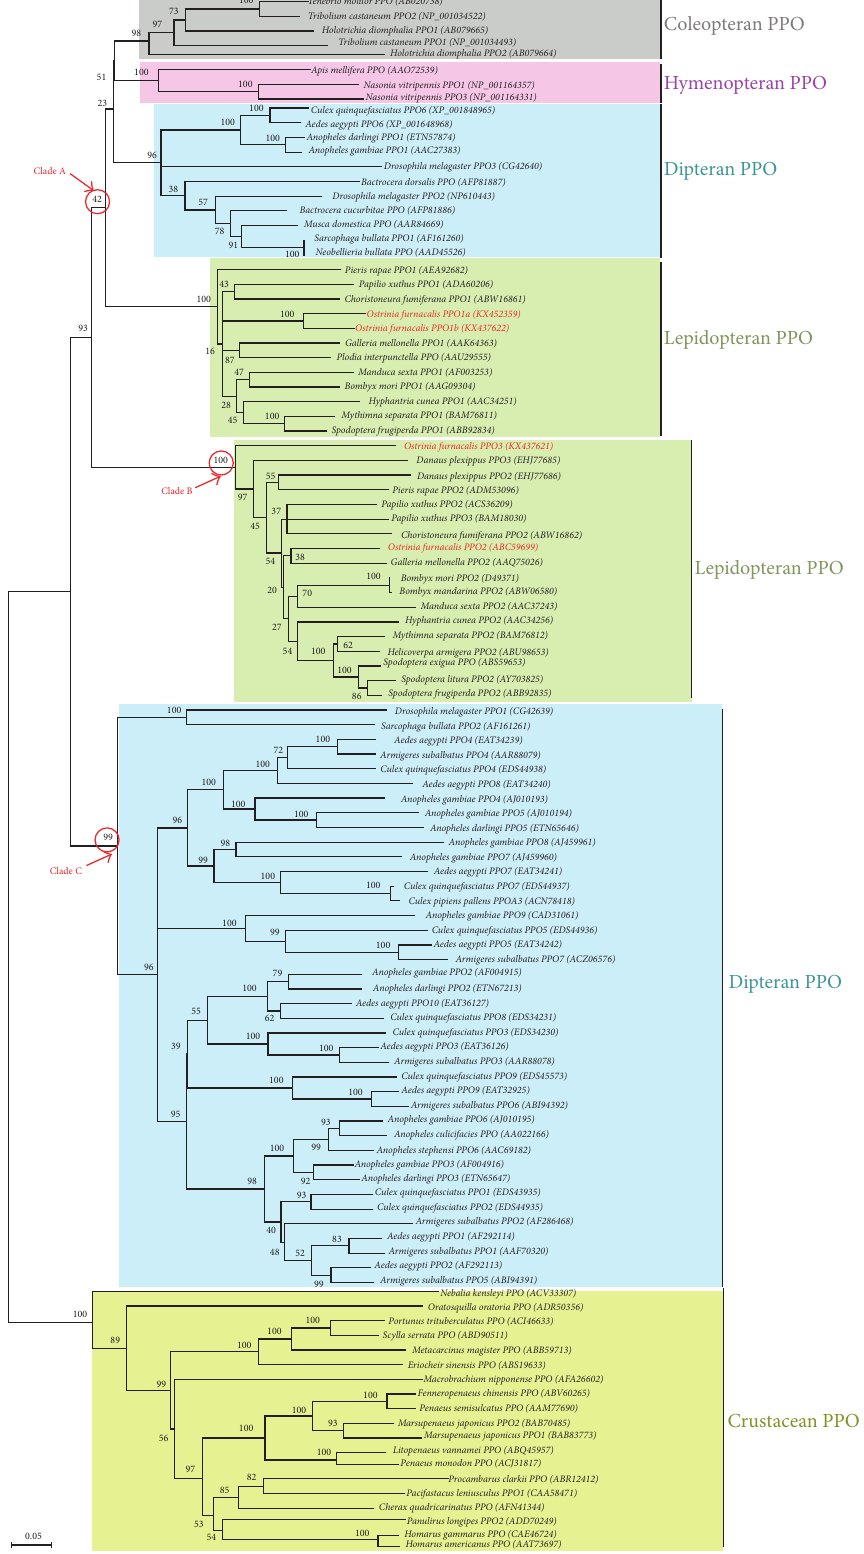
Figure 4: Phylogenetic analysis of O. furnacalis PPOs with other homologs. The used amino acid sequences of 108 PPOs were from 34 insect species and 18 crustacean species. The names of PPO genes were shown as scientific name of species followed by NCBI accession number of the gene. The O. furnacalis PPOs are marked in red. The branches specific for coleopteran, hymenopteran, dipteran, lepidopteran, and crustacean PPOs, respectively, are shaded in squares. Numbers at the nodes are bootstrap values as percentage. The circled bootstrap values indicate that the used insect PPOs were divided into three